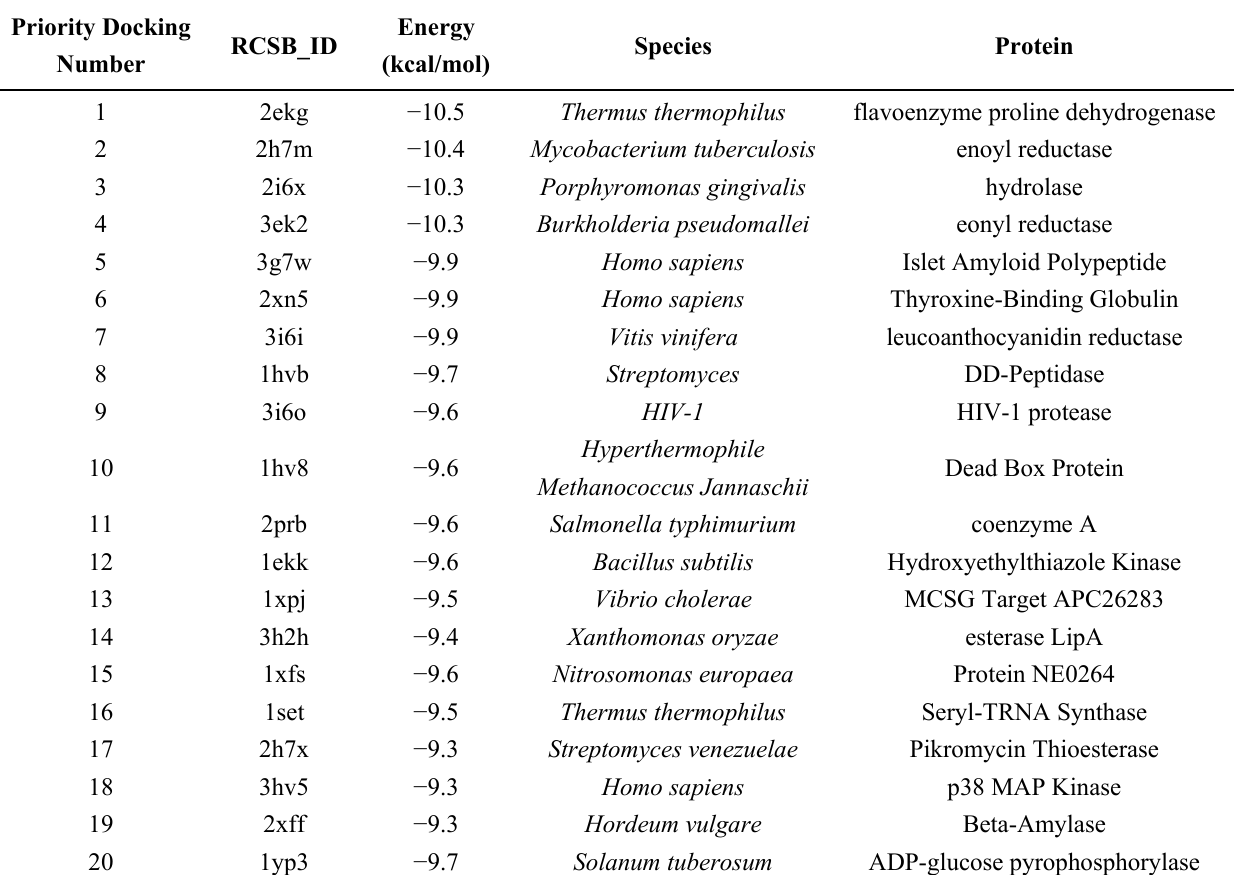
Table 1. Top twenty docking results identified using the paclitaxel ligand docking program Artemis